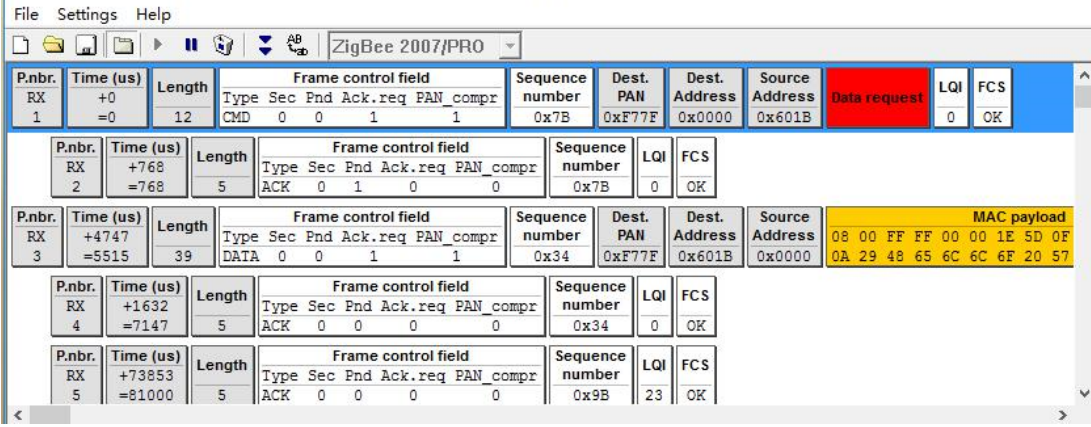
Figure 9. ZigBee data captured by Packet Sni ff